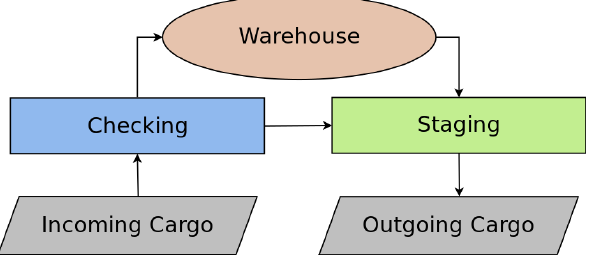
Figure 2. Summary of warehouse logistics process [43] (© 2019 IEEE). Arrows indicate the flow direction of the Incoming Cargo and Outgoing Cargo